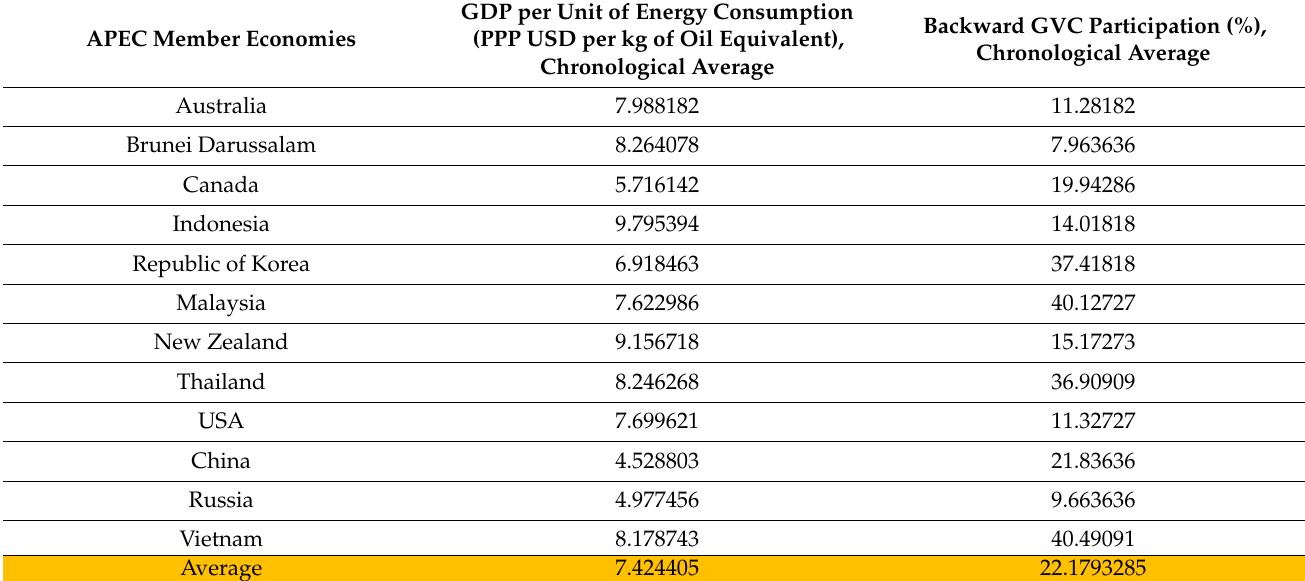
Table 9. APEC member economies with lower GDP per unit of energy